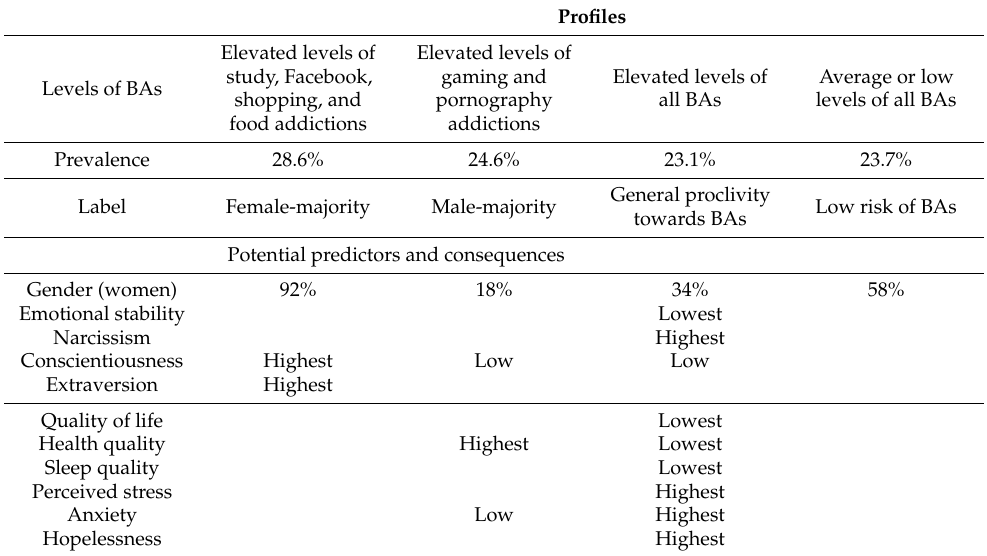
Table 1. Description of the Four Profiles of Behavioral Addictions (BAs).